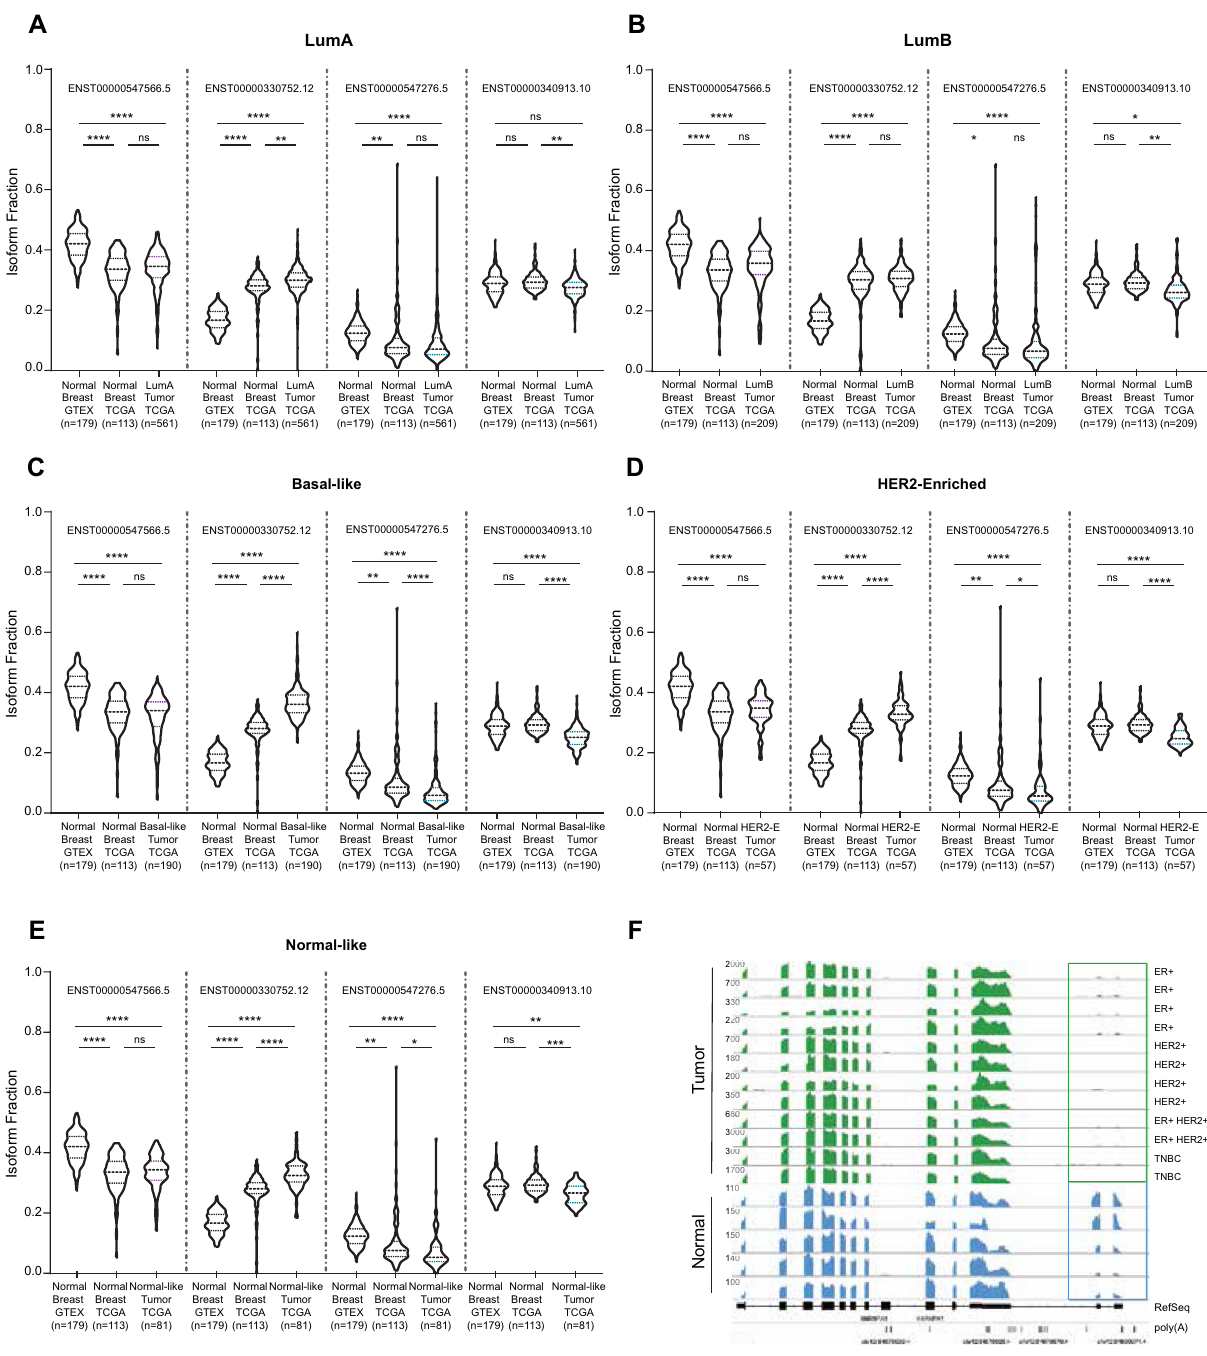
Figure 2. Isoform fractions of HNRNPA1 isoforms (Isoform-1, 2, 3, 4) in normal breast (GTEX), normal adjacent tissue (TCGA), and in Luminal A ( A ), Luminal B ( B ), Basal-like ( C ), HER2-enriched ( D ), Normal-like breast cancers ( E ) in the TCGA dataset (*p < 0.05, **p < 0.01, ***p < 0.001, ****p < 0.0001, one-way ANOVA, Tukey’s HSD), ( F ) Representative single-cell RNA-seq data for normal cell types and in breast cancer cells (GSE75688, GSE113197). The boxed area shows the reads from the exons unique to